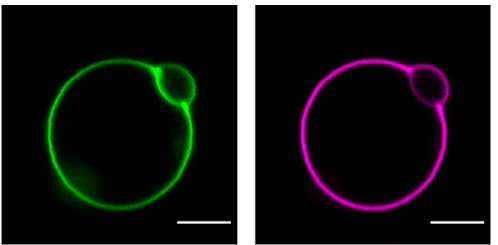
Figure 3. Confocal images of cholesterol and protein distribution in a GUV incubated with HDL (unpublished data, E. Sezgin): GUVs prepared from 1-palmitoyl-2-oleoyl- glycero-3-phosphocholine (POPC) were incubated with 0.05 mg/mL dual fluorescently labeled HDL particles (Cholesterol-BodipyFL (green), HDL-associated proteins-Atto647N (magenta)). Scale bar: 5 µm.